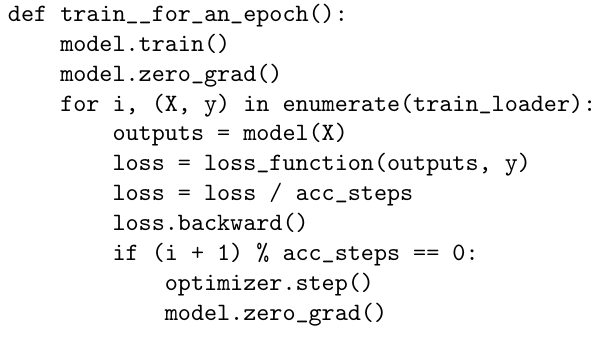
Figure A2. Python code for accumulating gradients in